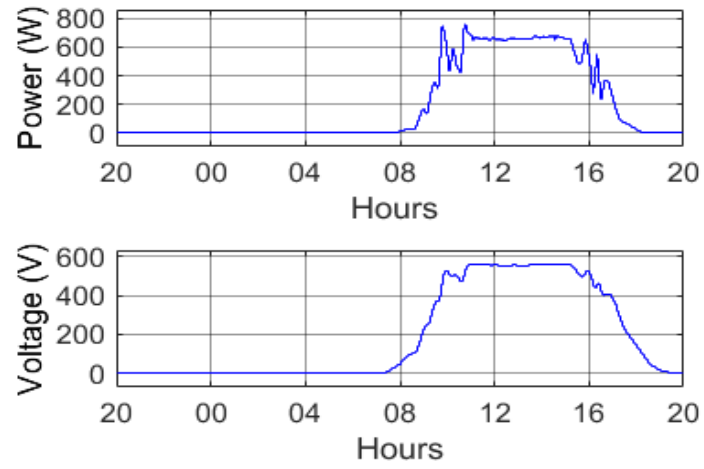
Figure 14. Power and voltage of the PV generator.